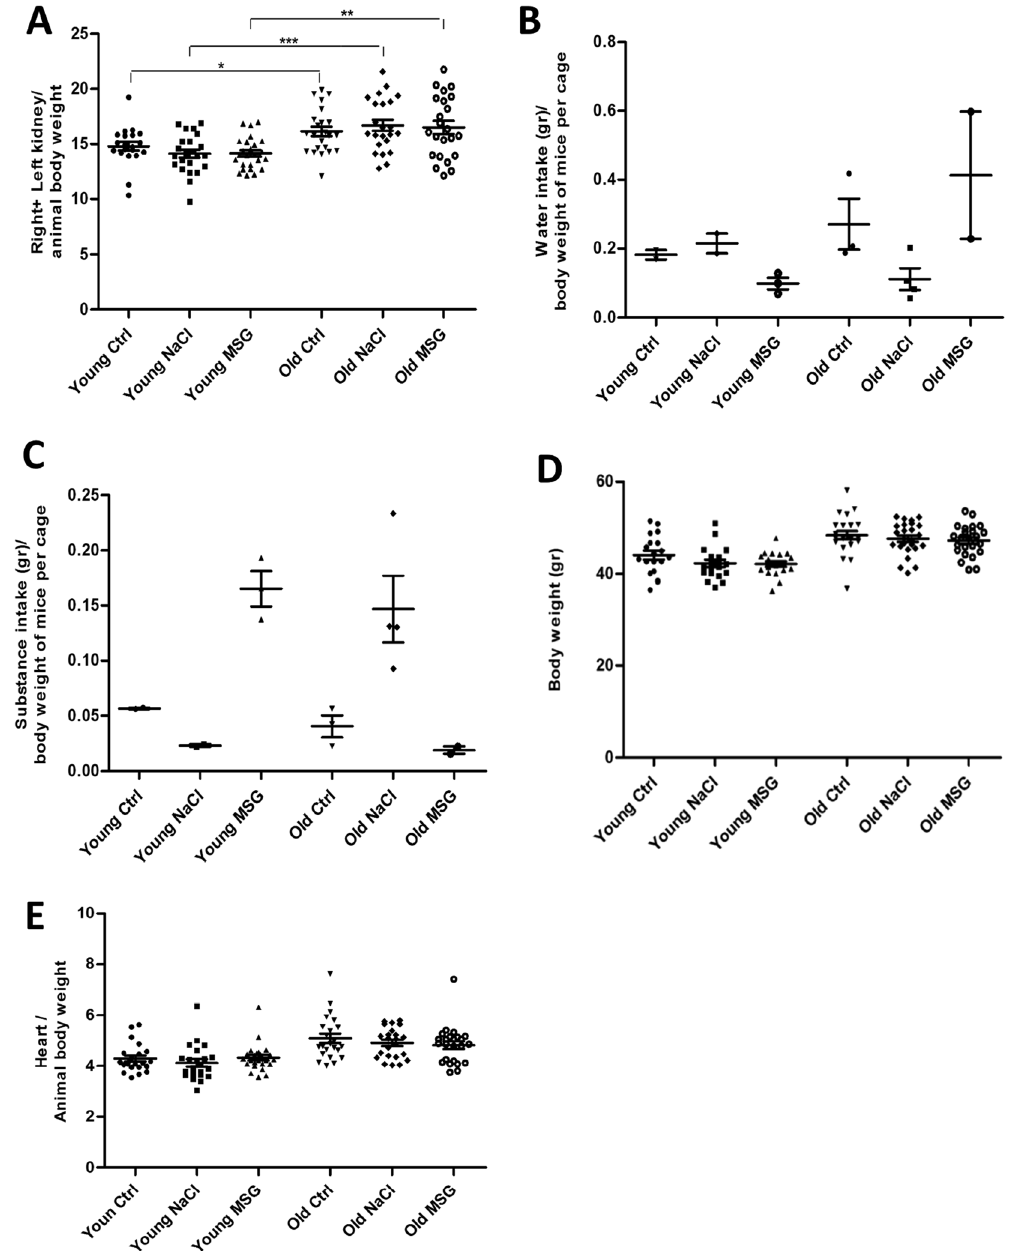
Figure 2. Kidney weight and water/substance intake measurements. ( A ) Ratio of total kidney (left plus right) weight to body weight in 6 months (young) or 18 months (old) old mice groups. An increase in kidney weight was associated with aging in each treatment group (n = 21 in each group. t test: * p < 0.05, ** p < 0.01, *** p < 0.001). ( B, C ) Water ( B ) and ( C ) substance (Water, NaCl and MSG respectively) consumption normalized by total mouse weight within a cage. ( D ) Body weight at the end of treatment. ( E ) Heart weight normalized to body weight (mg/g) at the end of